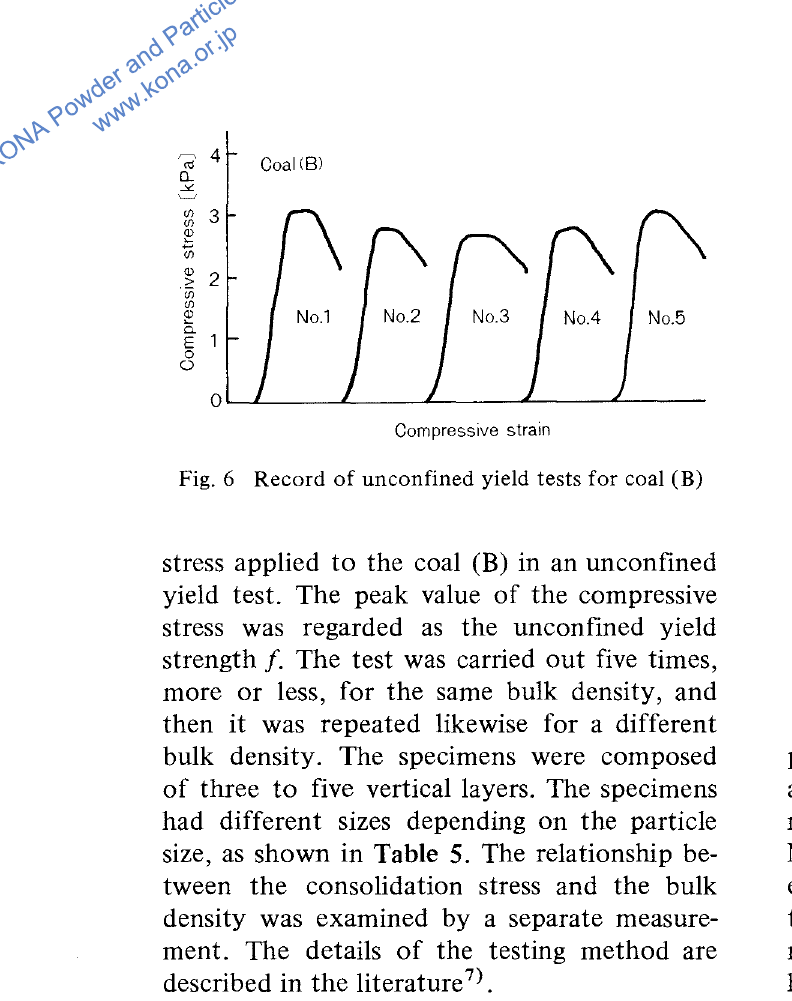
Fig. 6 Record of unconfined yield tests for coal (B)